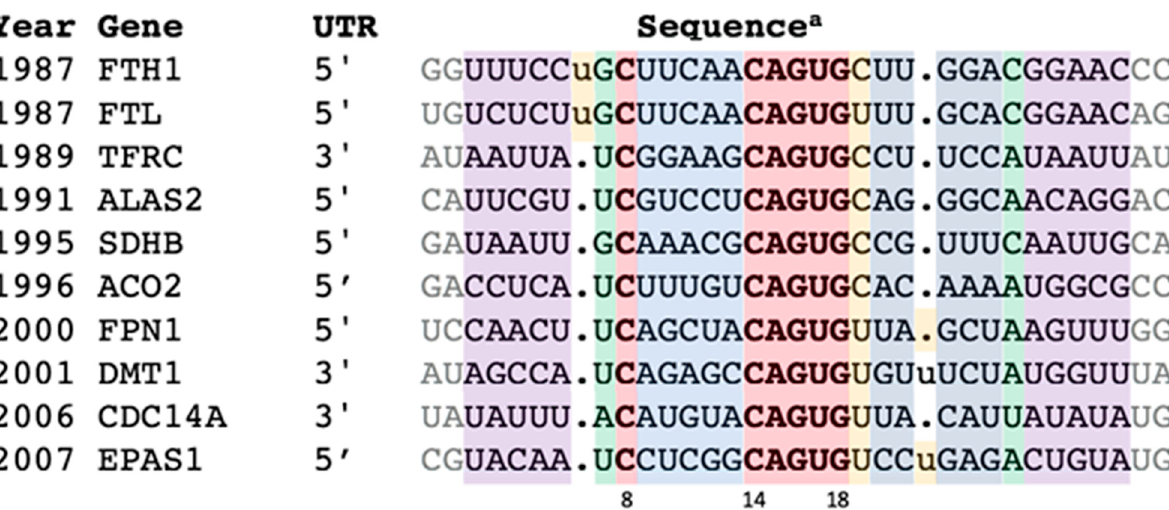
Figure 1. Representative IREs of genes regulated by the IRE:IRP system. a All sequences from H. sapiens except SDHB from D. melanogaster . Features color coded as in Figure 2. The extended set of orthologues is in Table S1, and alignment details in Figures S1 and S2. References: FTH1: [3,4,13–15]; FTL: [3,13–15]; TFRC: [16]; ALAS2: [5,17,18]; SDHB: [19,20]; ACO2: